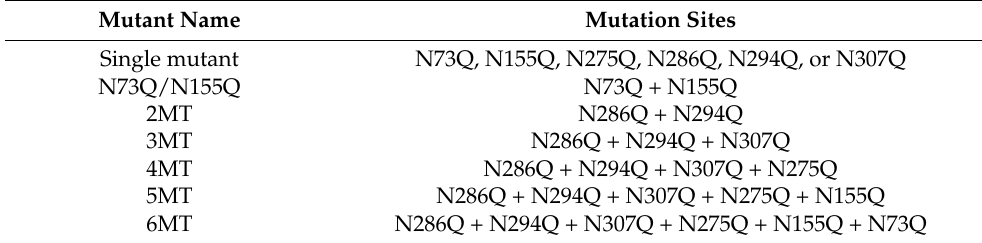
Table 1. N -Glycosylation mutants of